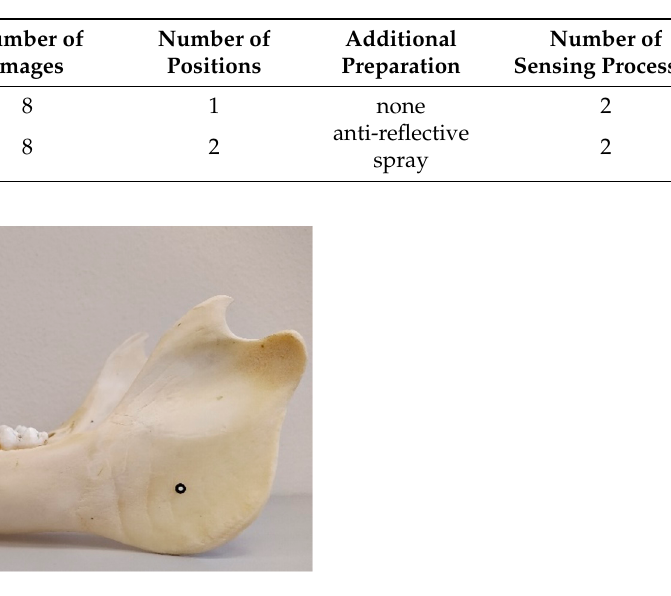
Table 1. Object scanning process.